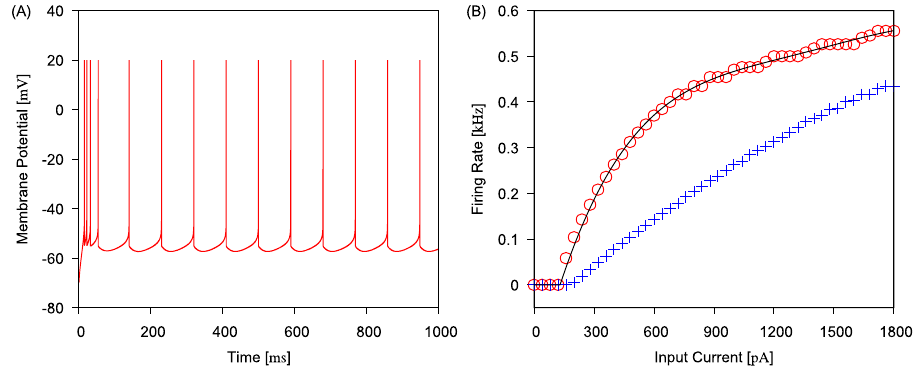
Figure 2. Response of a single neuron modeled by Eq. (1). ( A ) Traces of the membrane potential response evoked by a steady input current are shown. Parameter values were set as a u = 4.0 nS, b u = 50 mA and = I 300 mA inputX . ( B ) Firing rate of a neuron versus input current I inputX is plotted. Circles show results of simulations without SFA and solid line shows a fit by the polynomial given in Eq. (10). Crosses show results of simulations with